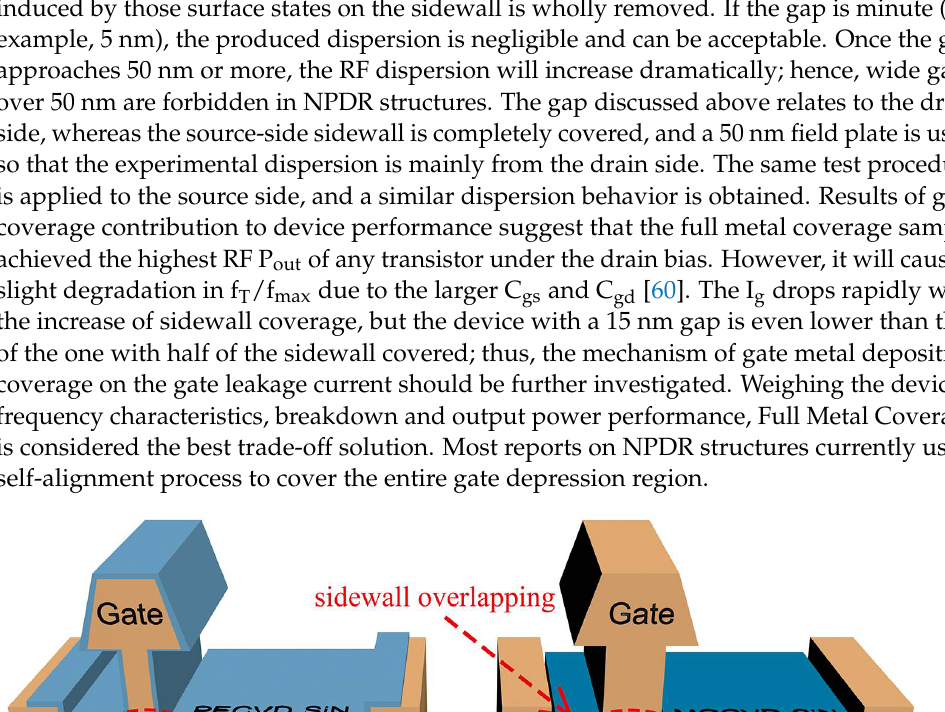
Figure 11. 3D model of NPDR MIS-HEMTs. ( a ) Without gate-sidewall overlapping; ( b ) with gate- sidewall overlapping.